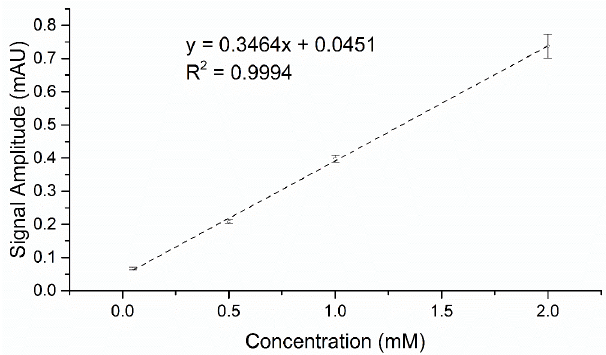
Figure A3. The CE linear detection range of 2,3-dihydrobenzo-1,4-dioxin-5-ol in a 96-well MTP format.